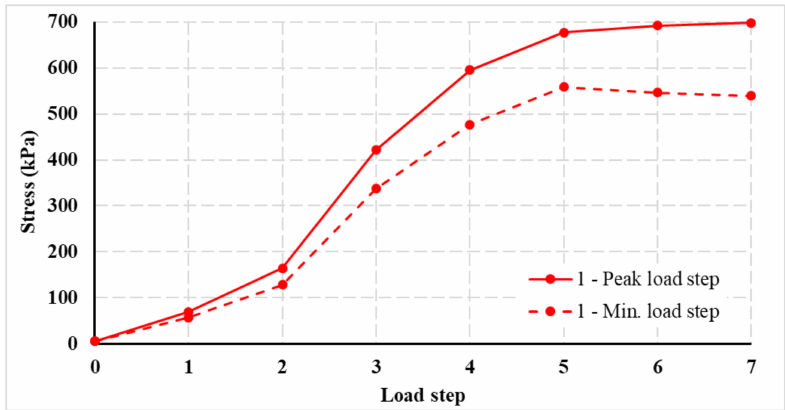
Figure 26. Example of stress for pressure cell 1 in the first layer (foundation joints)—centrically loaded slab